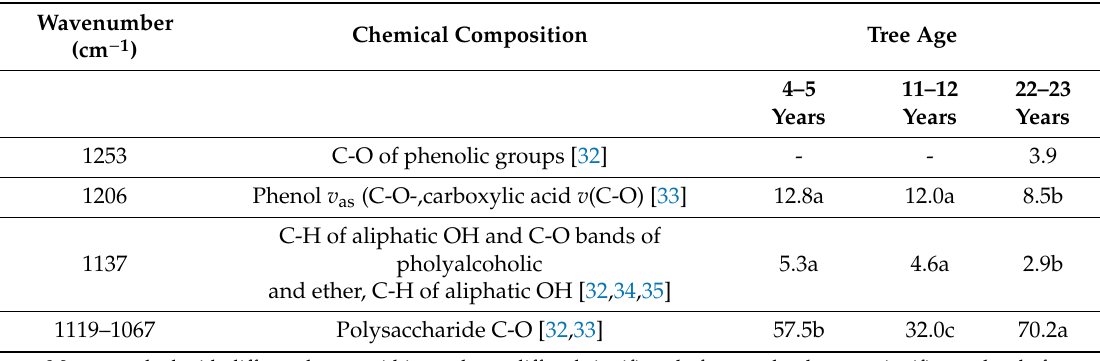
Table 3. Assigned Fourier transform infrared (FTIR) integrated areas of di ff erent ages of rubber tree